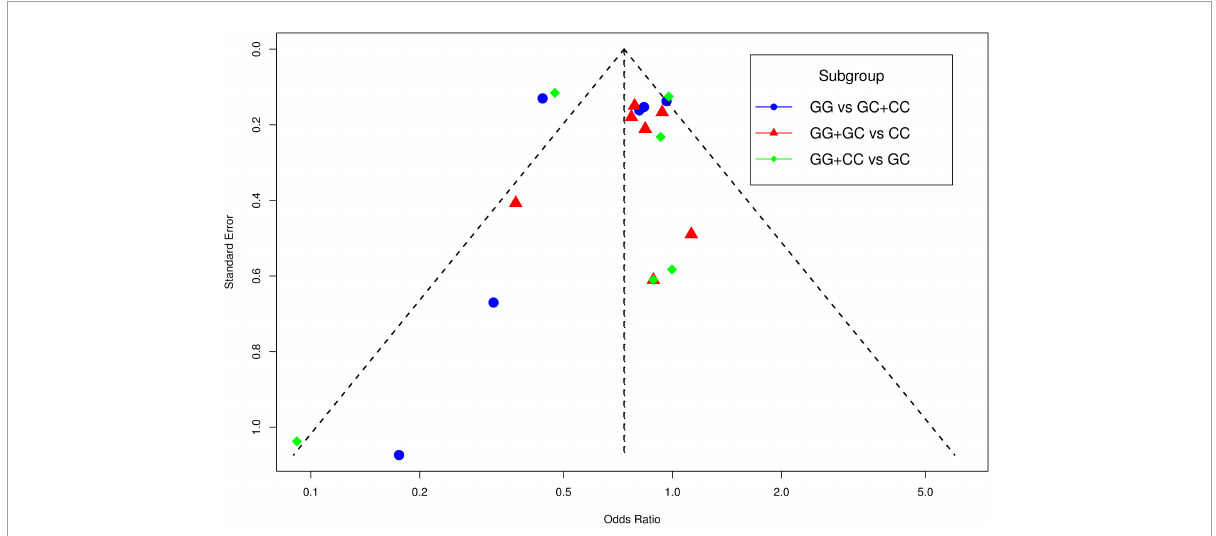
FIGURE5 The funnel plots for publication bias analyses of selected studies investigating the association between rs9349407 and Alzheimer’s disease